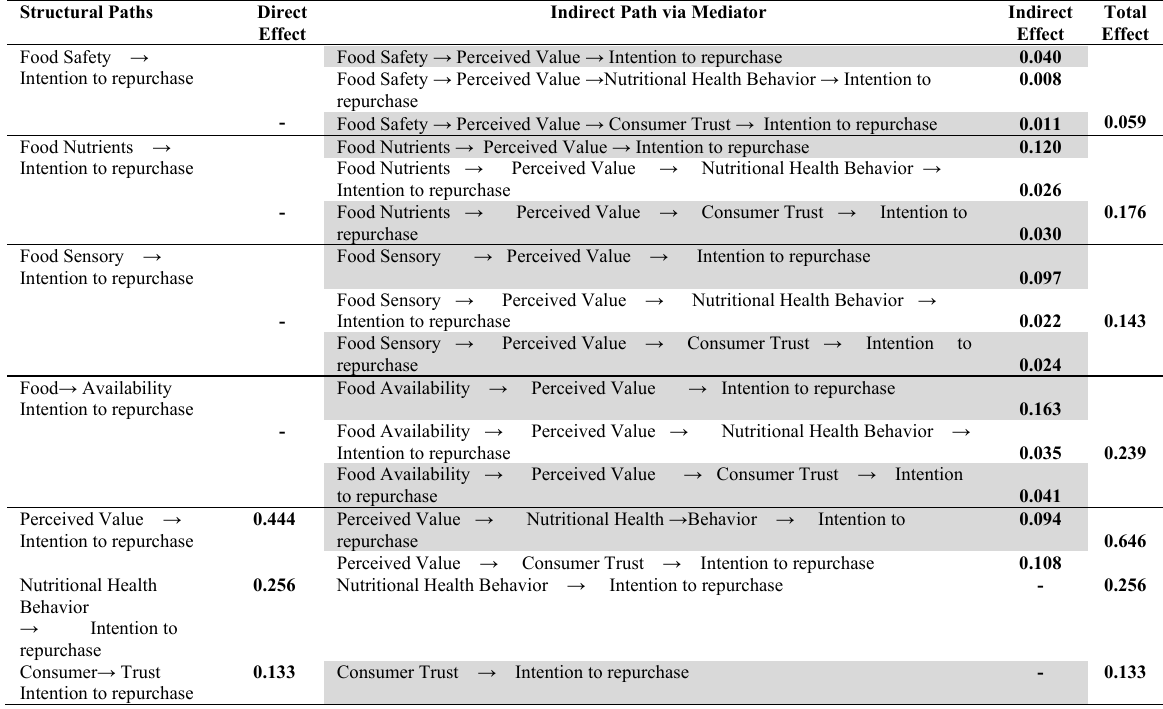
Direct Effect, Indirect Effect and Total Effect of Intention to